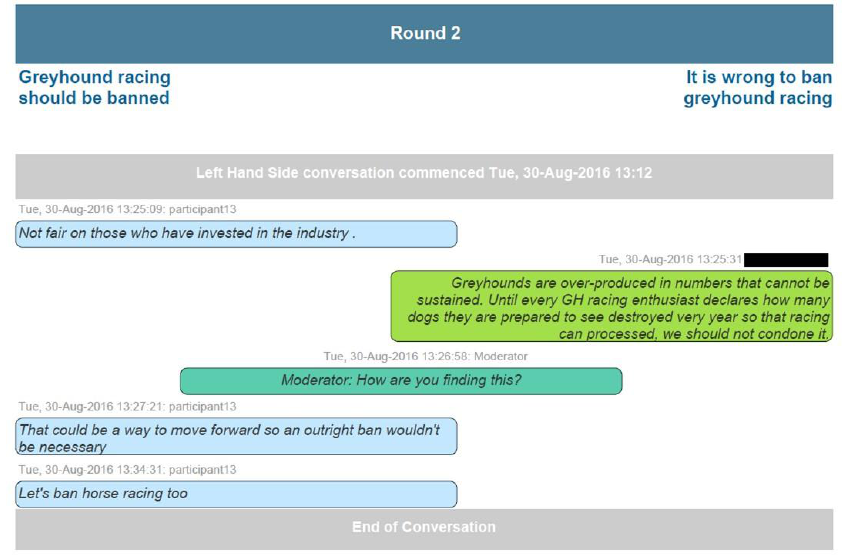
Figure 3. A screen grab from a summary of participation in a VHC session.